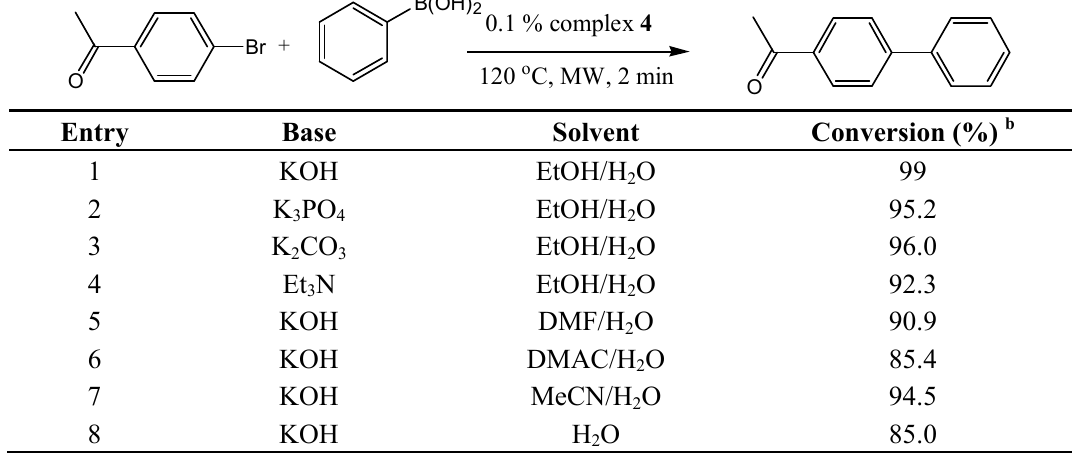
Table 1. Optimization of base and solvent for Suzuki cross-coupling reaction under microwave irradiation a .